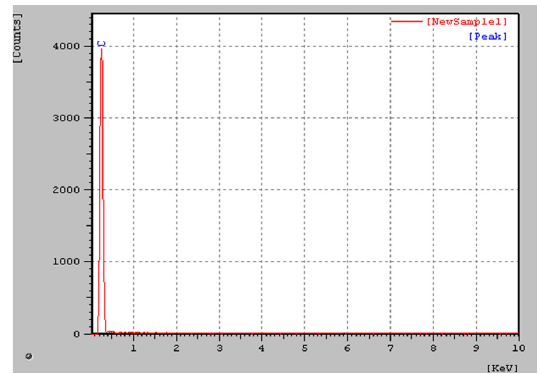
Figure 11. EDS analysis of uncoated diamond in point 01 of Figure